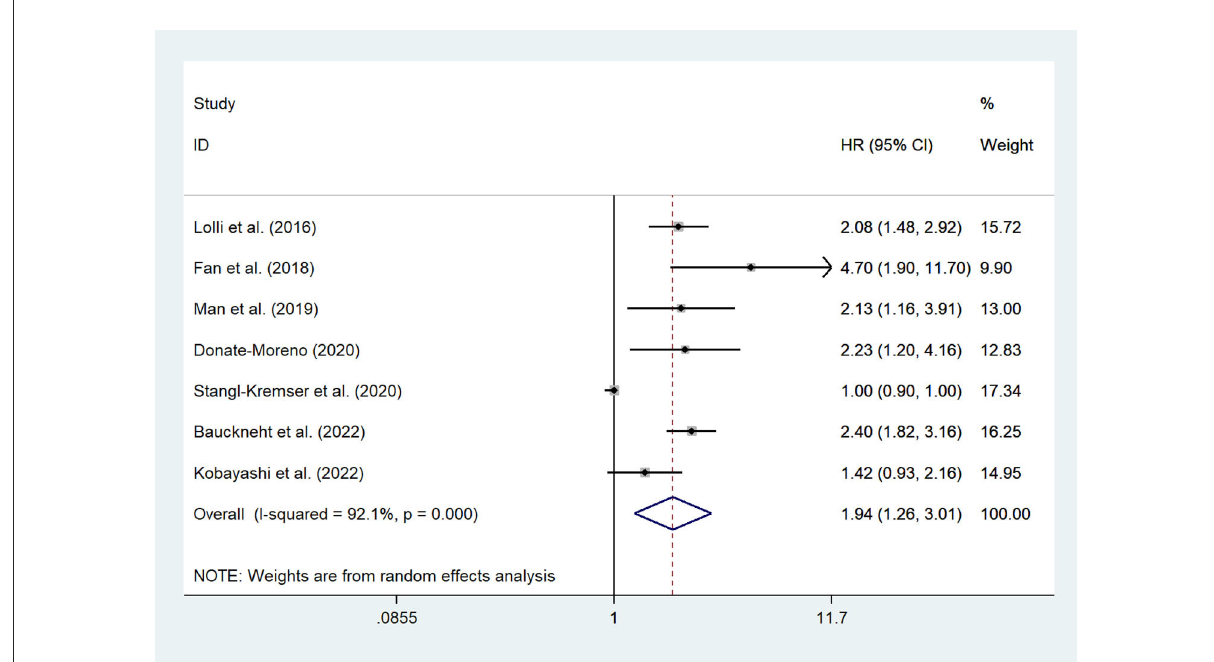
FIGURE2 Forest plot of the association between SII and OS in mCRPC patients. SII, systemic immune-inflammation index; OS, overall survival; mCRPC, metastatic castration-resistant prostate cancer.